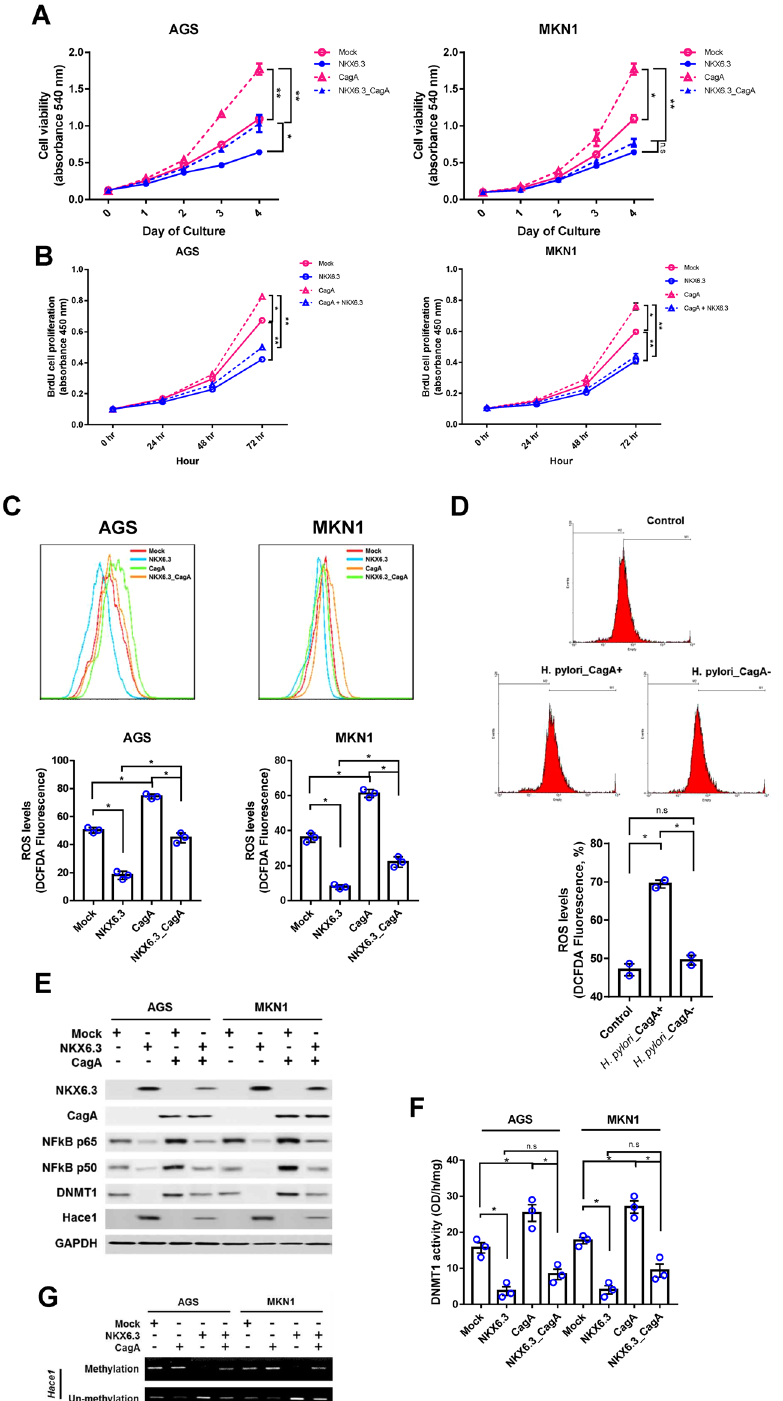
Figure 6. NKX6.3 suppresses the effects of H . pylori CagA on cell growth, ROS production, NF-kB signaling pathway and DNMT1 activity. ( A and B ) CagA induced a time-dependent increase in cell viability (A) and cell proliferation (B), but the expression of NKX6.3 inhibited the stimulatory effects of CagA on cell viability and proliferation. Results are represented as mean ± SEM from three independent experiments. (C) NKX6.3 abrogated CagA-induced ROS production in NKX6.3 stable cells. (D) CagA increased the expression of NF-kB p65, p50 and DNMT1 proteins and induced loss of Hace1 expression, but NKX6.3 markedly inhibited the CagA effects on expression of these proteins. (E) CagA enhanced DNMT1 activity in AGS and MKN1 cells, but NKX6.3 suppressed the CagA-induced DNMT1 activity. Results are represented as mean ± SEM from three independent experiments. (F) NKX6.3 inhibited CagA-induced hypermethylation of Hace1 gene. Each dot plot represents the result from the individual experiment. ** P < 0.005, * P < 0.05, based on the student’s